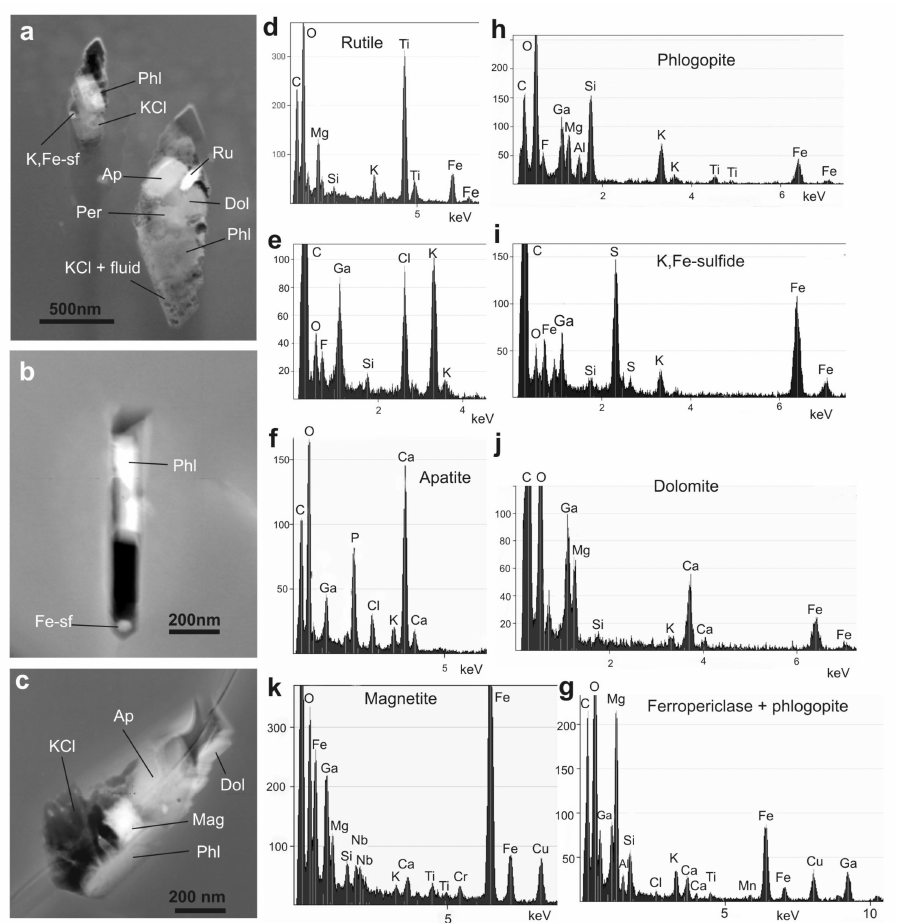
Figure 5. ( a – c ) TEM bright field image of the nanometer-sized polyphase inclusions: diamond HI-111, foil #2798, inclusions 2, 3 ( a ); diamond HI-105, foil #2802, inclusion 1 ( b ) and 2 ( c ). The main phases are indicated: Ru (rutile), Phl (phlogopite), Ap (apatite), Dol (dolomite), Mag